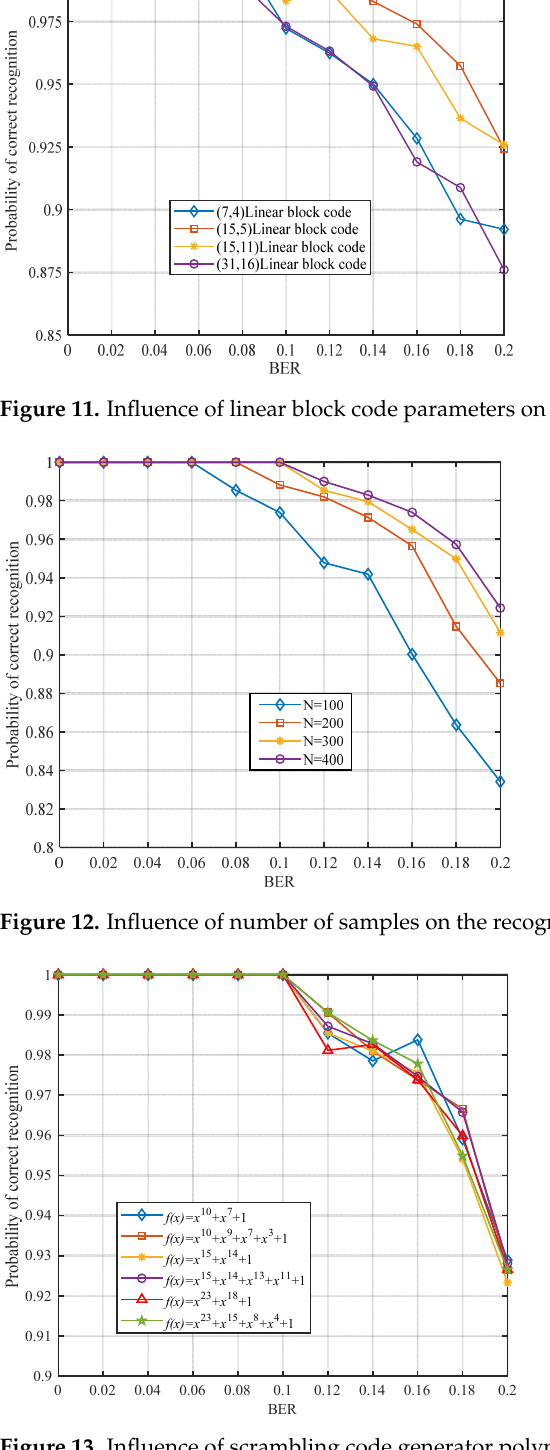
Figure 11. Influence of linear block code parameters on the recognition rate.